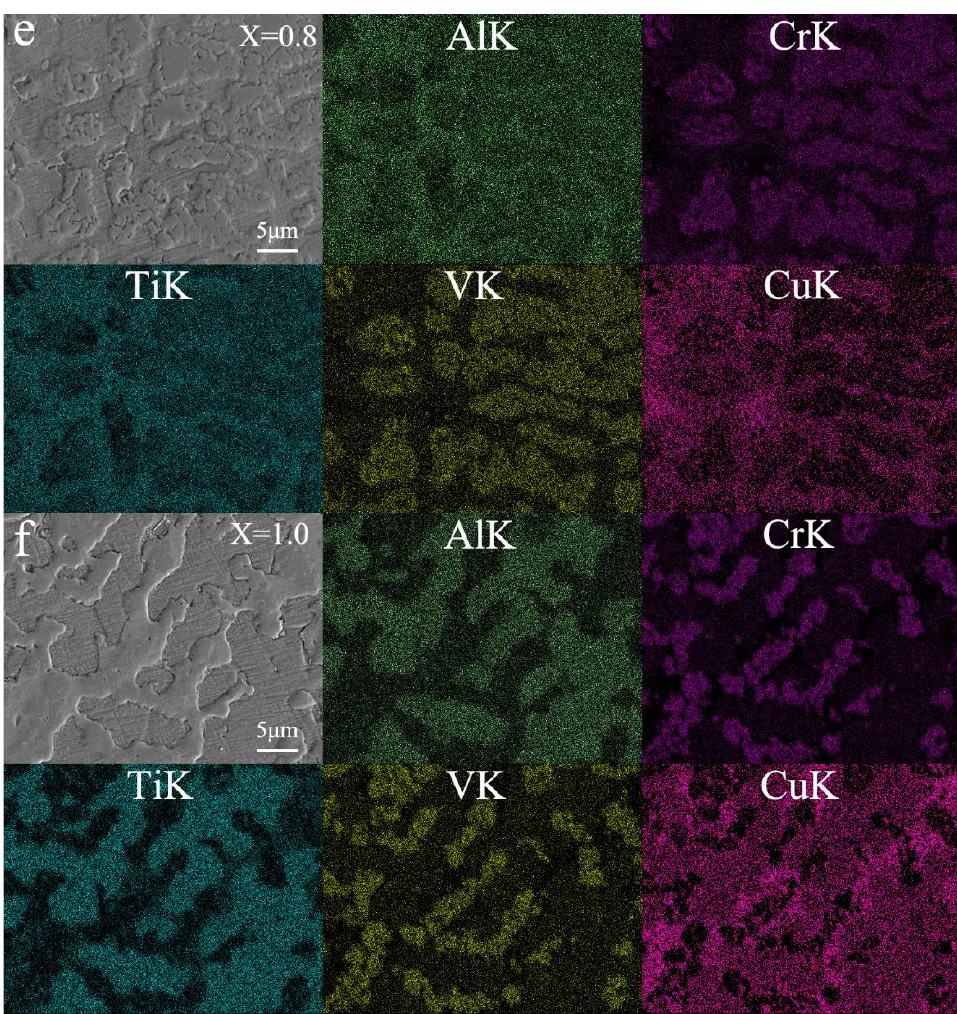
Figure 4. Elemental EDS mapping of AlCrTiV 0.5 Cu x lightweight HEAs. ( a ) x = 0; ( b ) x = 0.2; ( c ) x = 0.4; ( d ) x = 0.6; ( e ) x = 0.8; ( f ) x = 1.0.